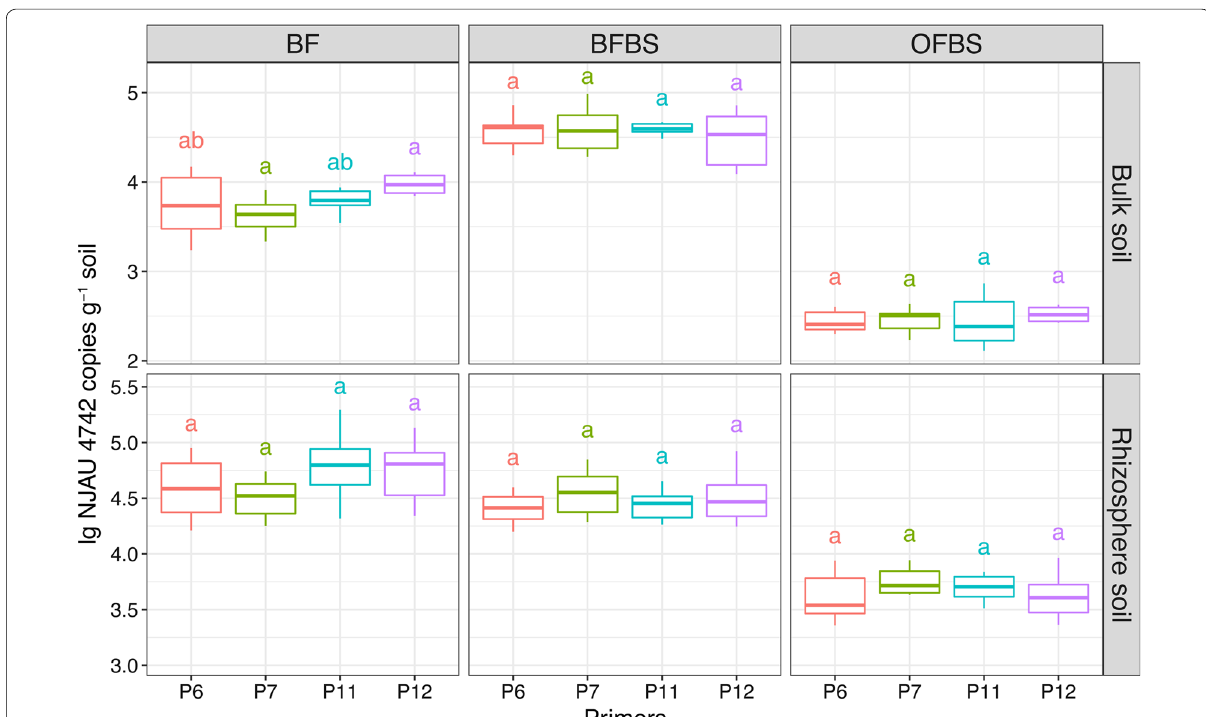
Fig. 3 Amounts of T. guizhouense NJAU 4742 detected by qPCR using primer pairs P6, P7, P11 and P12 in the soil collected for the pot experiment. Values are the means of three soil treatment replications using different strain-specific primers. The letters indicate significant differences among primers determined by the Tukey